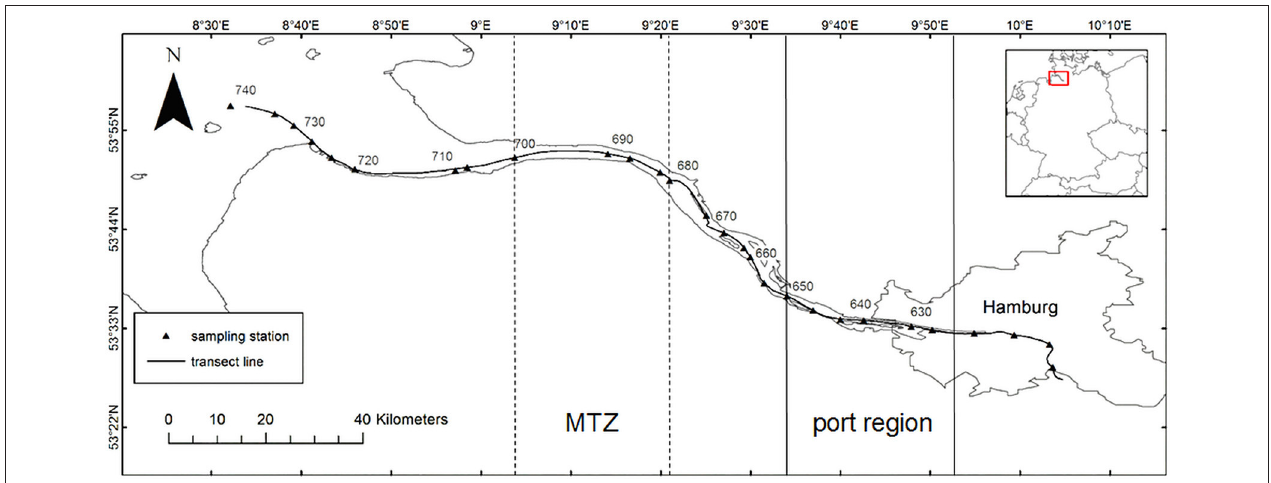
FIGURE 1 | The Elbe estuary with river stream km, transect line (black line) and stations for distinct sampling (triangles); MTZ, maximum turbidity zone.